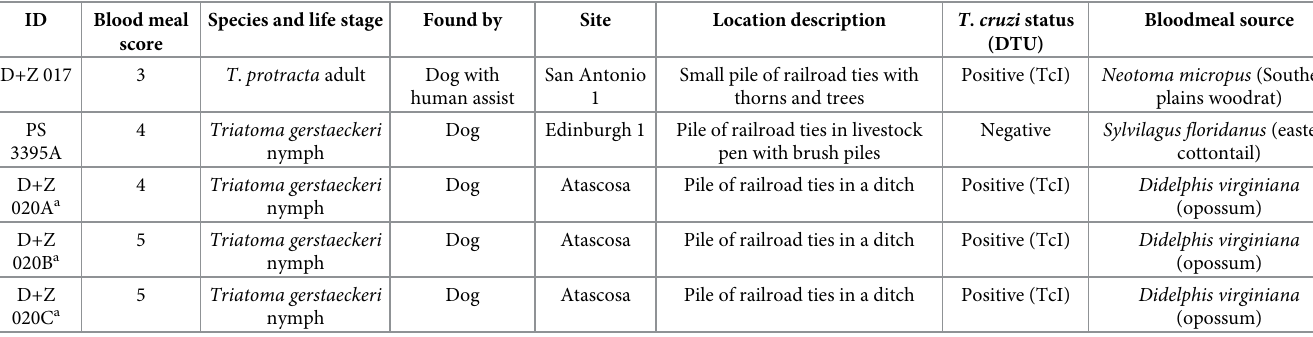
Table 3. Bloodmeal analysis of triatomines found by a scent detection dog.